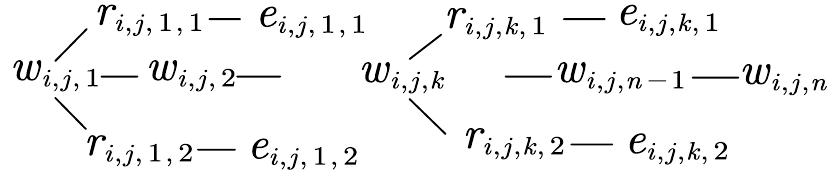
Figure 4. Knowledge aggregation tree structure diagram.